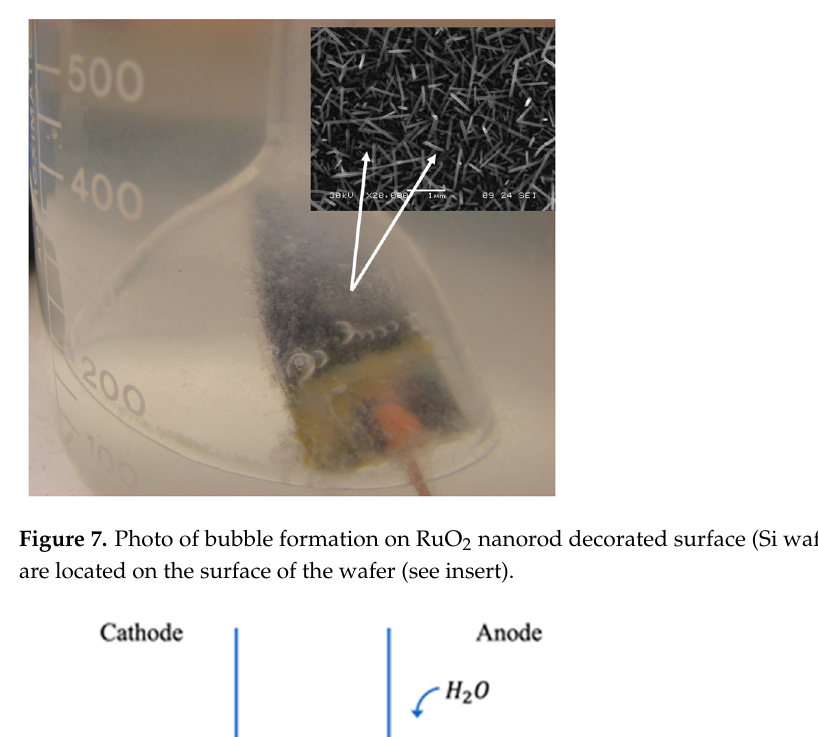
Figure 7. Photo of bubble formation on RuO 2 nanorod decorated surface (Si wafer). The nanorods are located on the surface of the wafer (see insert).